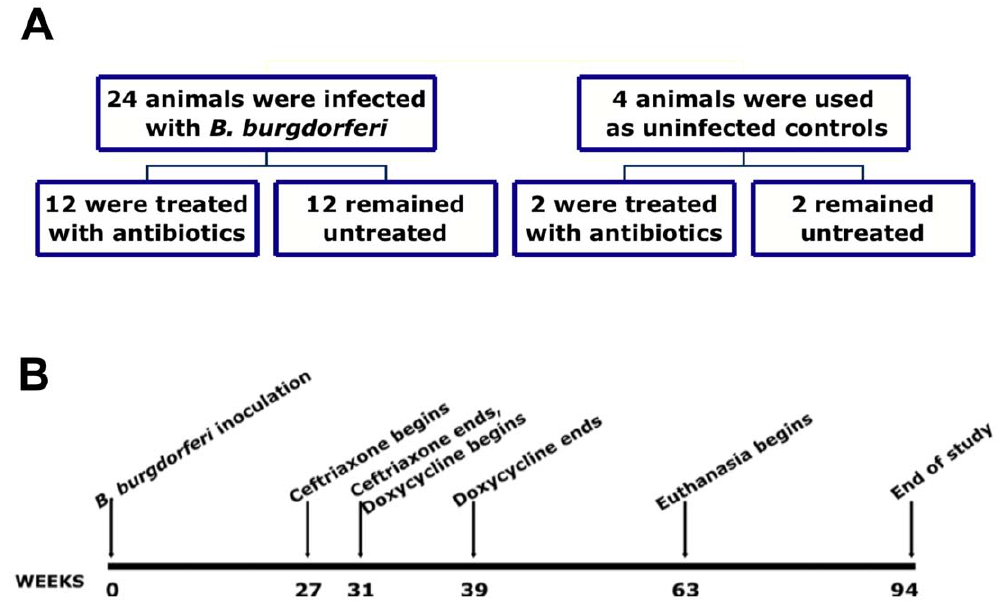
Figure 1. Experimental design for assessment of treatment efficacy in the late, disseminated phase of infection (Experiment 1). A) diagram of animal groups, showing inoculation ( B. burgdorferi or sham) and treatment groups (treated with antibiotics or untreated); and B) the time line of the study.